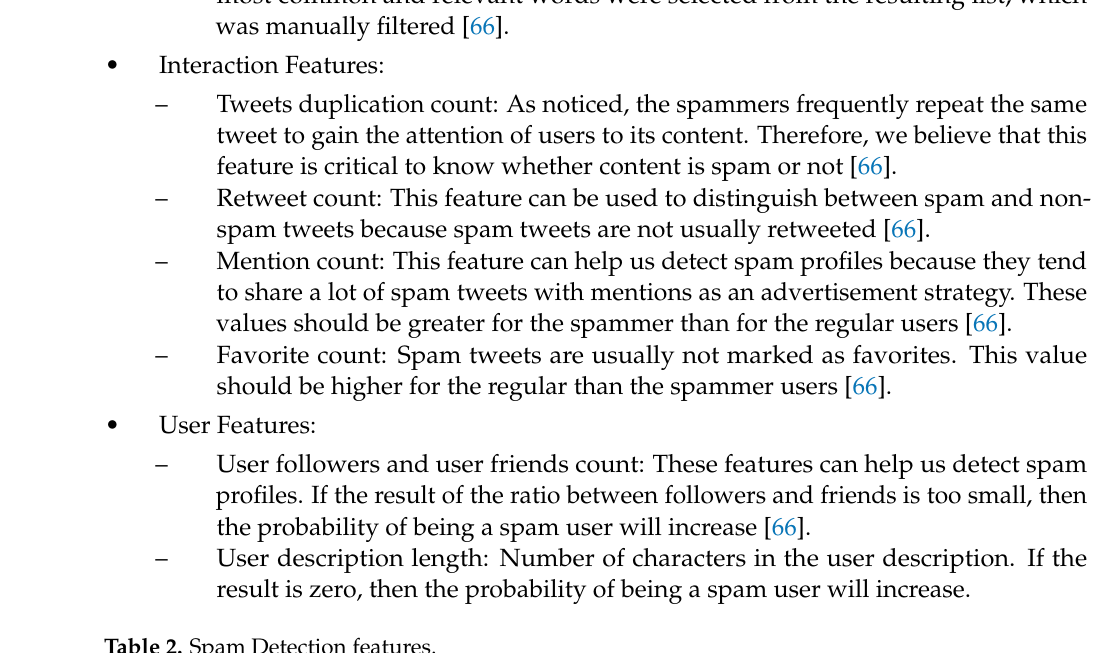
Table 2. Spam Detection